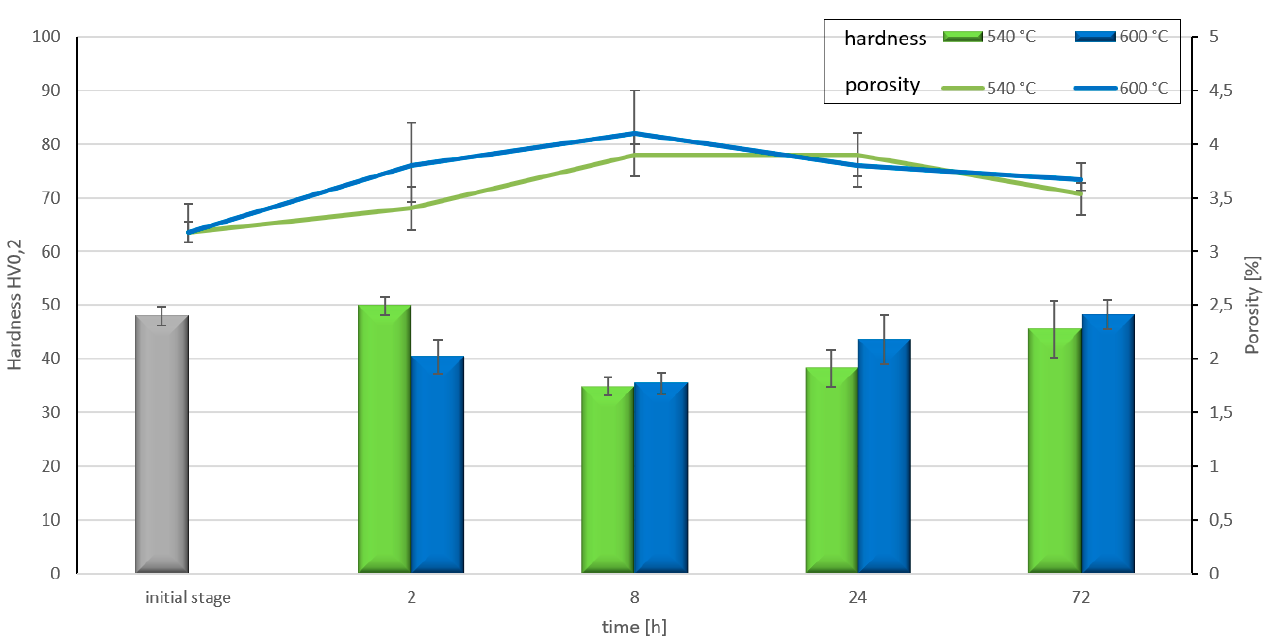
Figure 11. Phase composition for AMC-Ti-C composite after heat treatment at 540 ◦ C, over 8 and 72 h durations (XRD).